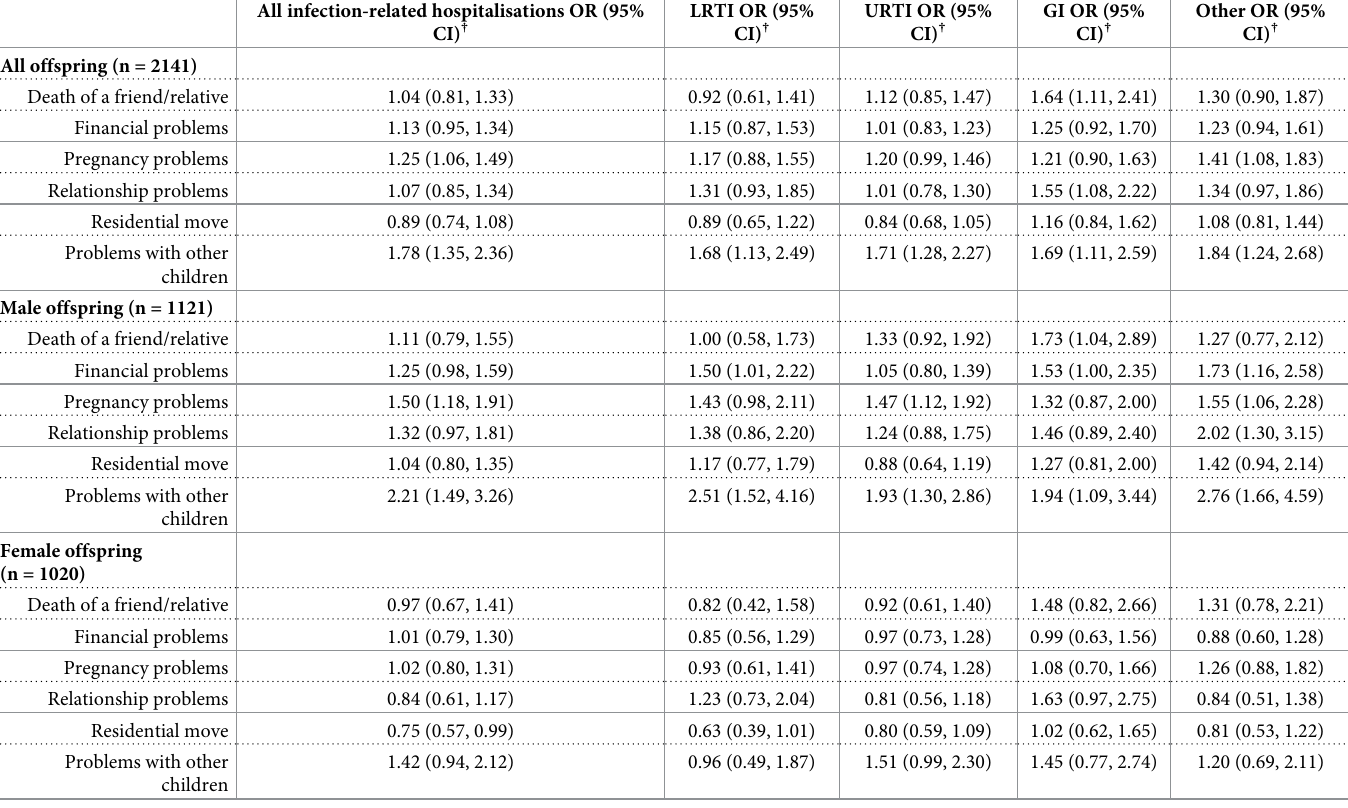
† odds ratio and 95% confidence intervals, each line reflects a separate logistic regression model. Model adjusted for maternal age at pregnancy, maternal education at pregnancy and maternal smoking in pregnancy. LRTI: Lower respiratory tract infection; URTI: Upper respiratory tract infection; GI: Gastrointestinal infection; Other: Genitourinary infection, skin and soft tissue infection or other viral infection.